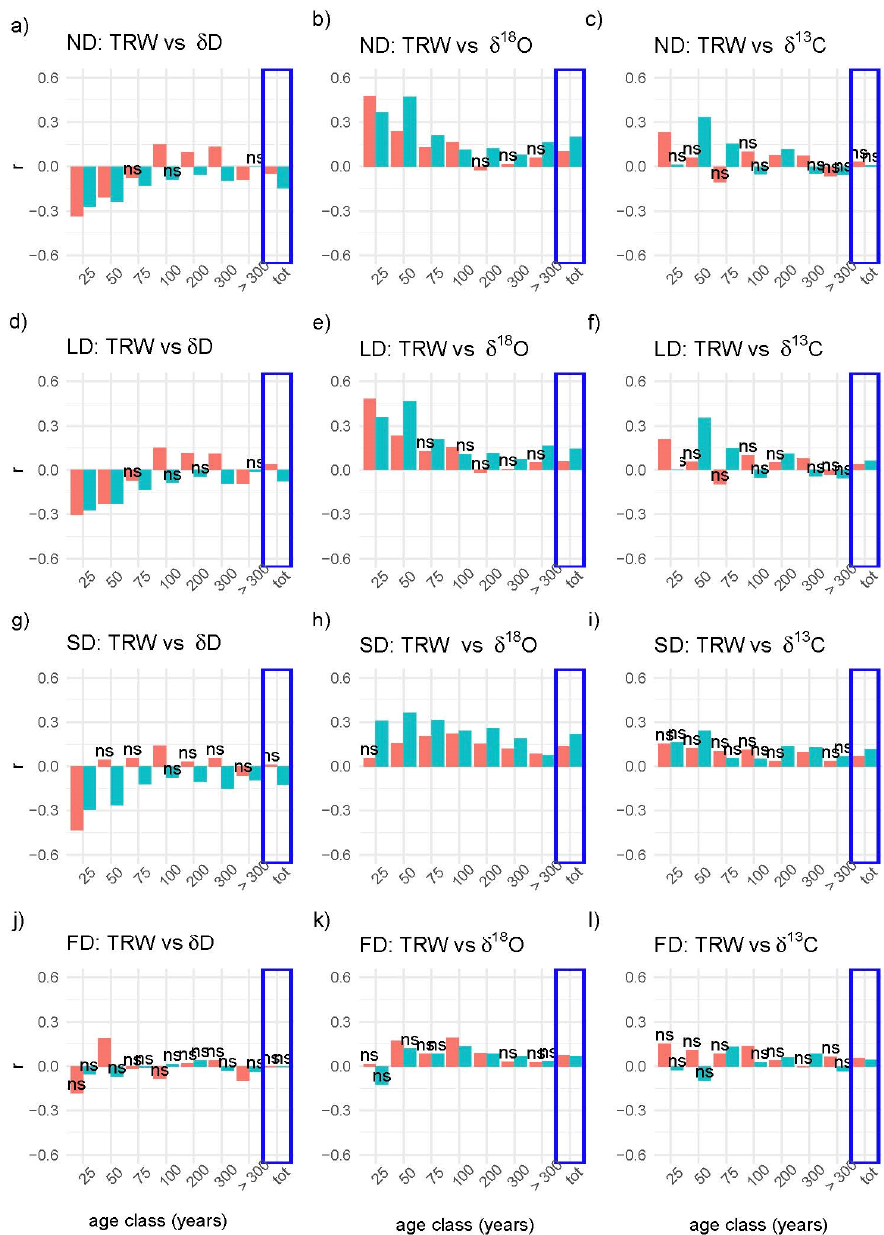
Figure 2. Correlations between TRW and stable isotopes. The correlation values were calculated using the Spearman method in each age class (1–25, 26–50, 51–75, 76–100, 101–200, 201–300, >300 years) and with the total data of each species (blue box). Larch values are red and those of cembran pine are turquoise. The correlation r values are displayed as histograms. The symbol “ns” on the column indicates that the correlation is non-significant ( p -value > 0.05). The upper plots titled ND show the correlations between the non-detrended values of isotopes and TRW ( a – c ), below are the LD plots that show the correlations between the TRW and the isotopes values that underwent linear detrending ( d – f ). Then, the SD plots showing the correlations of the TRW and isotope values detrended with a spline function are shown ( g – i ). The lowest FD plots show the correlations between the TRW and isotope values after first-difference time-series detrending (panels j – l